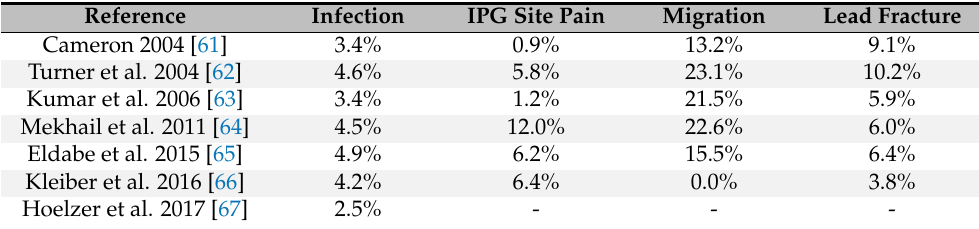
Table 4. Incidence of SCS complications in the